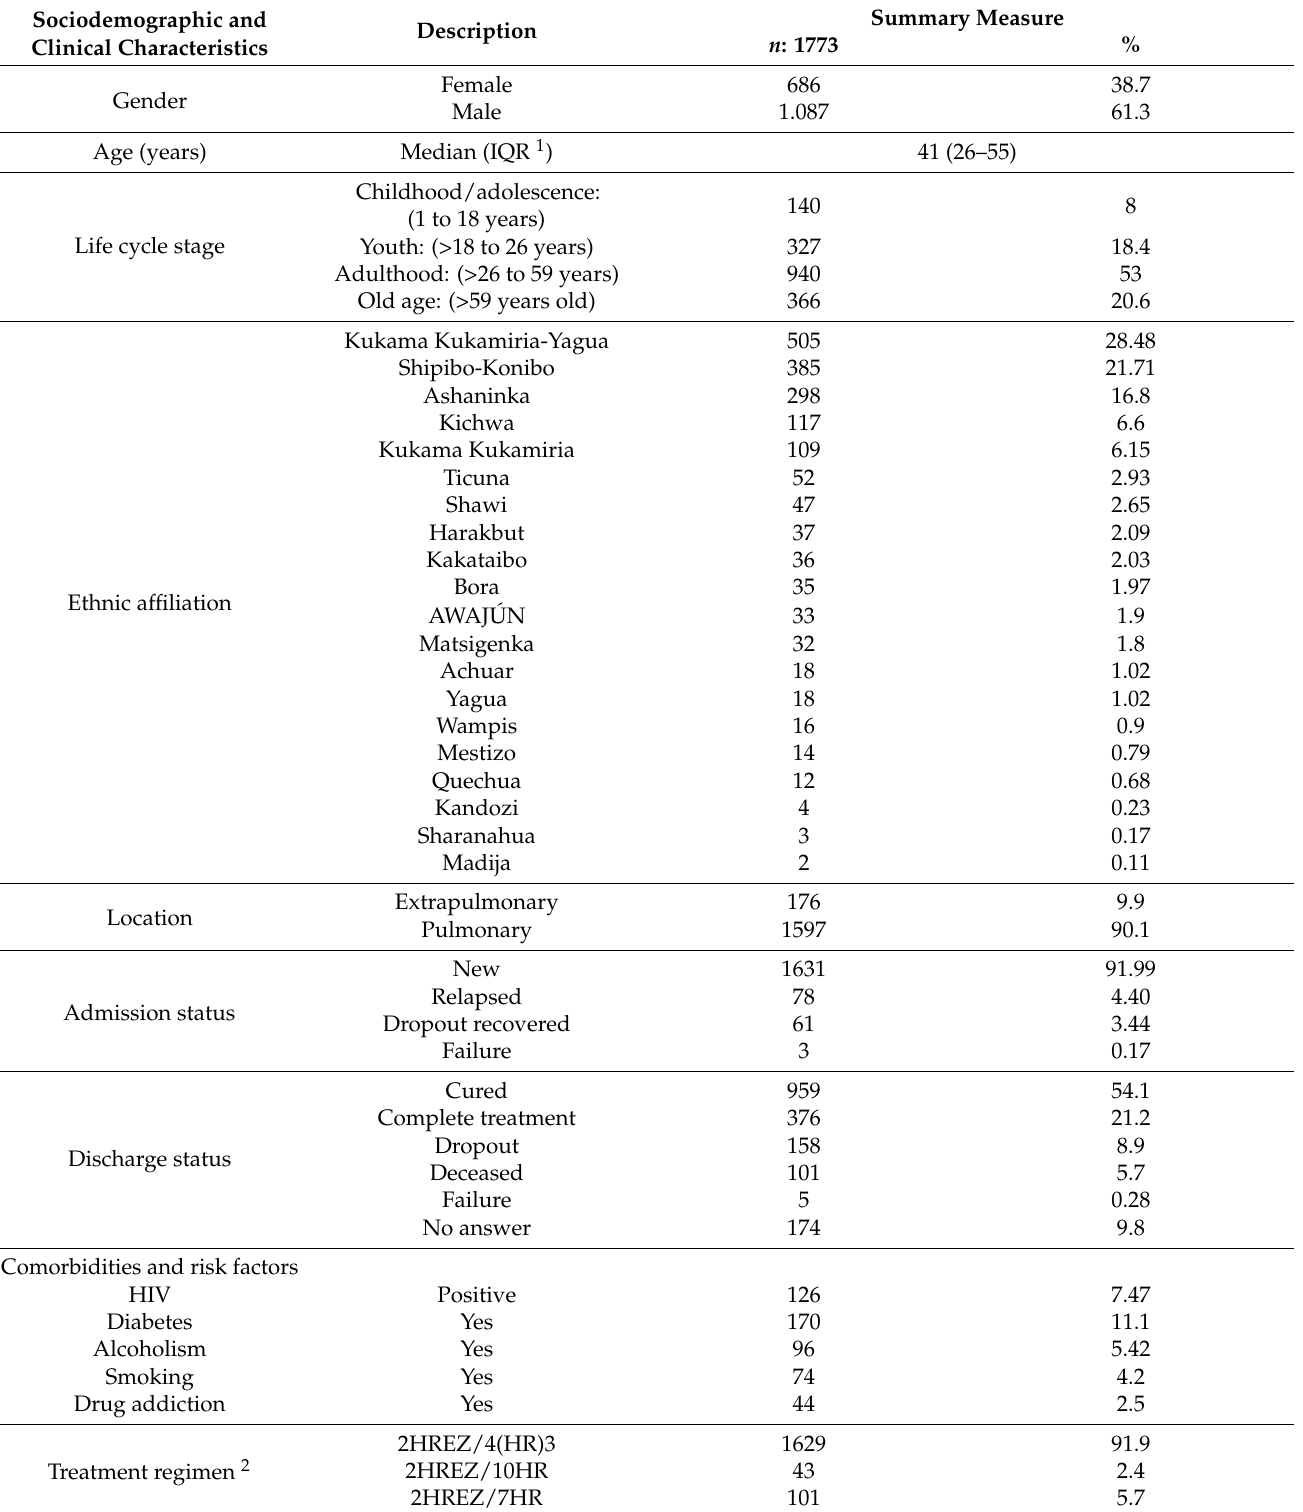
Table 2. Demographic characteristics of the indigenous population diagnosed with sensitive TB,